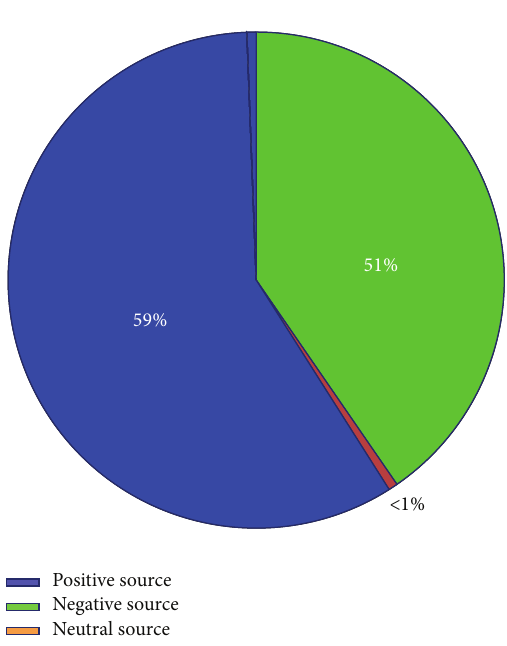
Figure 5: The distribution of three kinds of